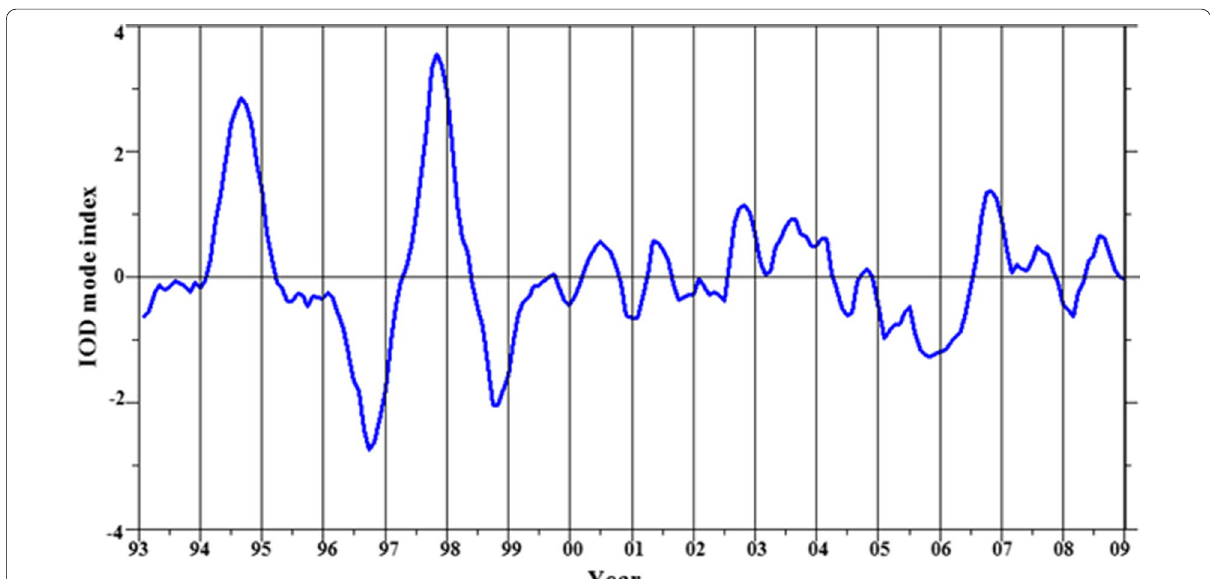
Fig. 7 Time series of the IOD index (prepared using the data from website http:// www. jamst ec. go.